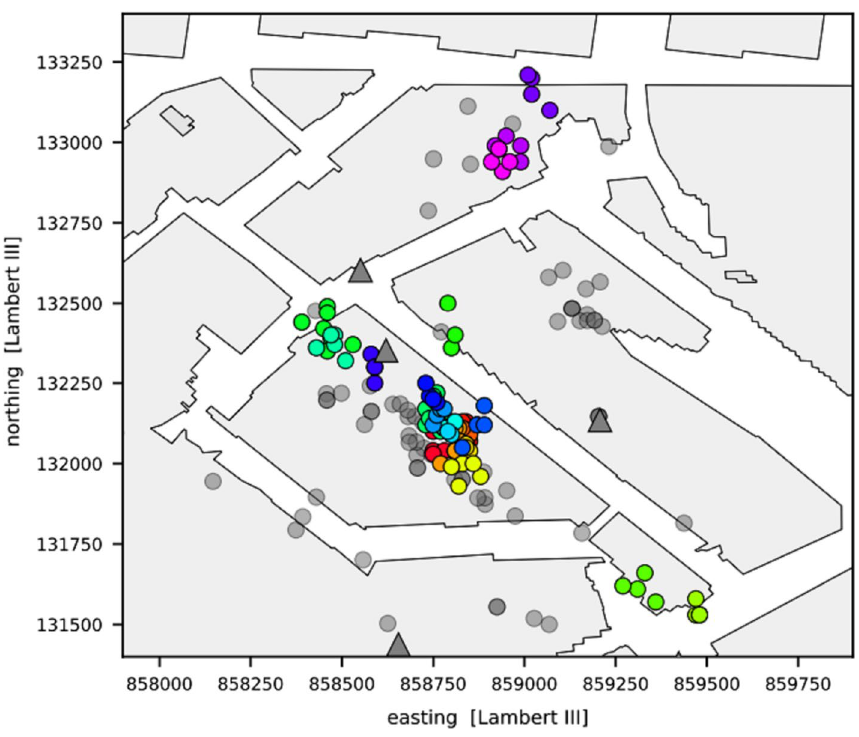
Fig. 6 Location of events of main multiplet families with more than 3 events. Grey circles indicate higher magnitude events ( M part of multiplet families (adapted from Namjesnik 2021)